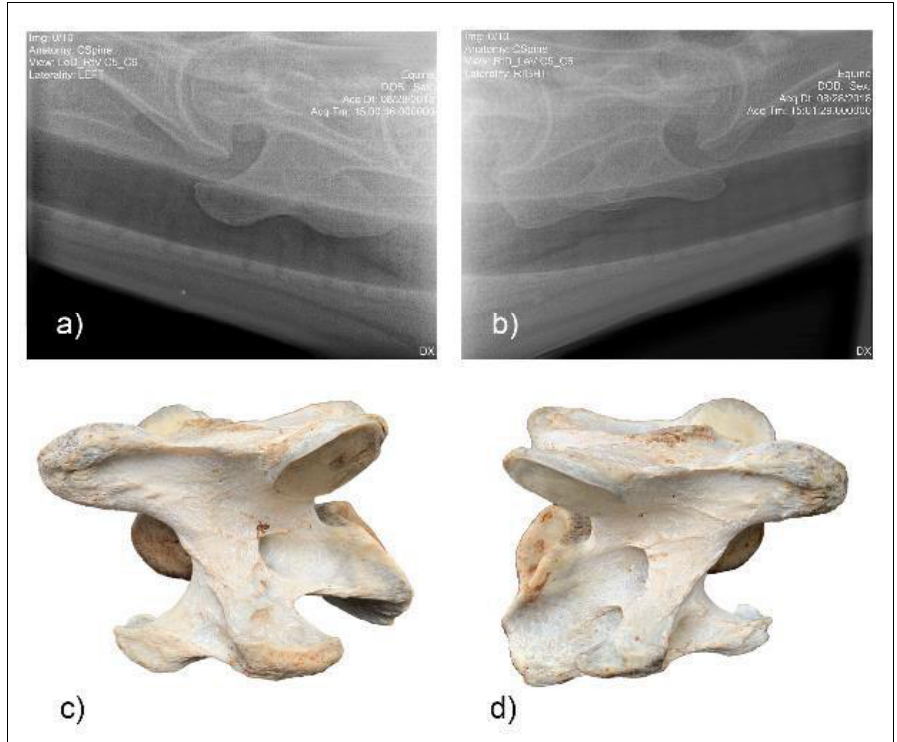
Figure 7. Radiographic images of the lateral 30° dorsal to ventral oblique left ( a ) and right ( b ) of C6 of horse F1 with the vertebrae left ( c ) and right ( b ) below. (Image ( b ) and ( d ) have been left in nonstandard orientation to appreciate the three-dimensional osseous form).